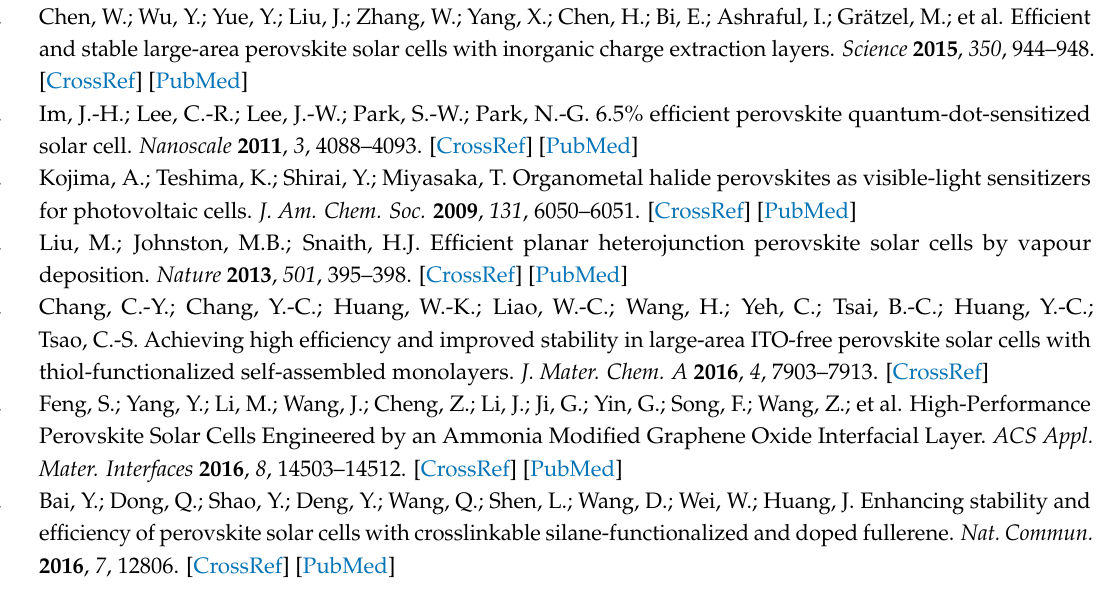
Figure S1: UV:Vis absorption spectra of MAPbI 3 perovskite absorber layer, Figure S2: (a) Surface and (b) Cross sectional SEM morphology of MAPbI3 perovskite absorber layer, Figure S3: Current Density of the device measured under various illumination levels where the net photocurrent is constant, (b) from mid forward bias to knee voltage, Figure S4: The variation of high and low frequency resistance as a function of V+JR S , Figure S5: A Mott-schottky (MS) plot of PSC at the frequency of 10 KHz in the bias range from 0 V to V OC , Figure S6: Variation of low frequency time constant as a function of applied bias for